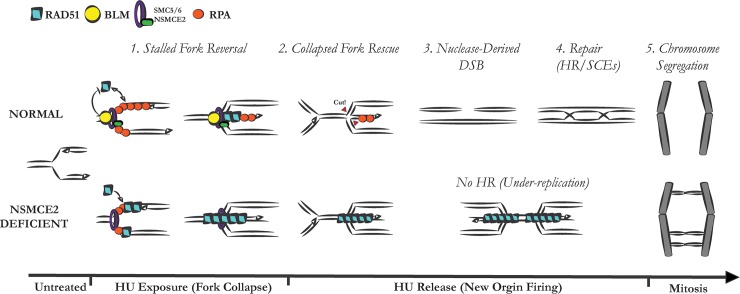
Model for collapsed-fork rescue by NSMCE2.Normally (top part of model), after exposure to HU, uncoupling of the replicative helicase from the replicative DNA polymerase at the fork leads to production of ssDNA, which is immediately bound by ssDNA binding protein RPA (red circle). BLM (yellow circle) is one of the first factors to be recruited to the stalled replication fork and this accumulation of BLM is dependent on the NSMCE2 protein (green rectangle) on the SMC5/6 complex (purple ring). The localization of BLM at the stalled fork assists in maintaining functional RAD51 (teal rhombus) exchange during fork reversal. Given enough time in the reversed configuration, the fork is unable to restart (fork collapse). After resumption of DNA synthesis at dormant origins, an active fork converges upon the collapsed fork. The convergence is associated with RAD51 dissociation and a DSB at the collapsed fork, followed by DSB repair by HR via the canonical RAD51-mediated pathway. In NSMCE2-deficient cells (bottom part of model), BLM is no longer recruited to the stalled fork, and there is a failure in the regulation of RAD51 loading at the fork, shown here as a loss of dynamic exchange of RAD51 and RPA resulting in excess, hyper-stable RAD51. After resumption of DNA synthesis at dormant origins, the aberrant RAD51 structure prevents convergence of the active fork with the collapsed fork, resulting in a double fork stall instead of a DSB. The double fork stall persists into mitosis where it results in an ultra-fine DNA bridge and mitotic DNA damage.